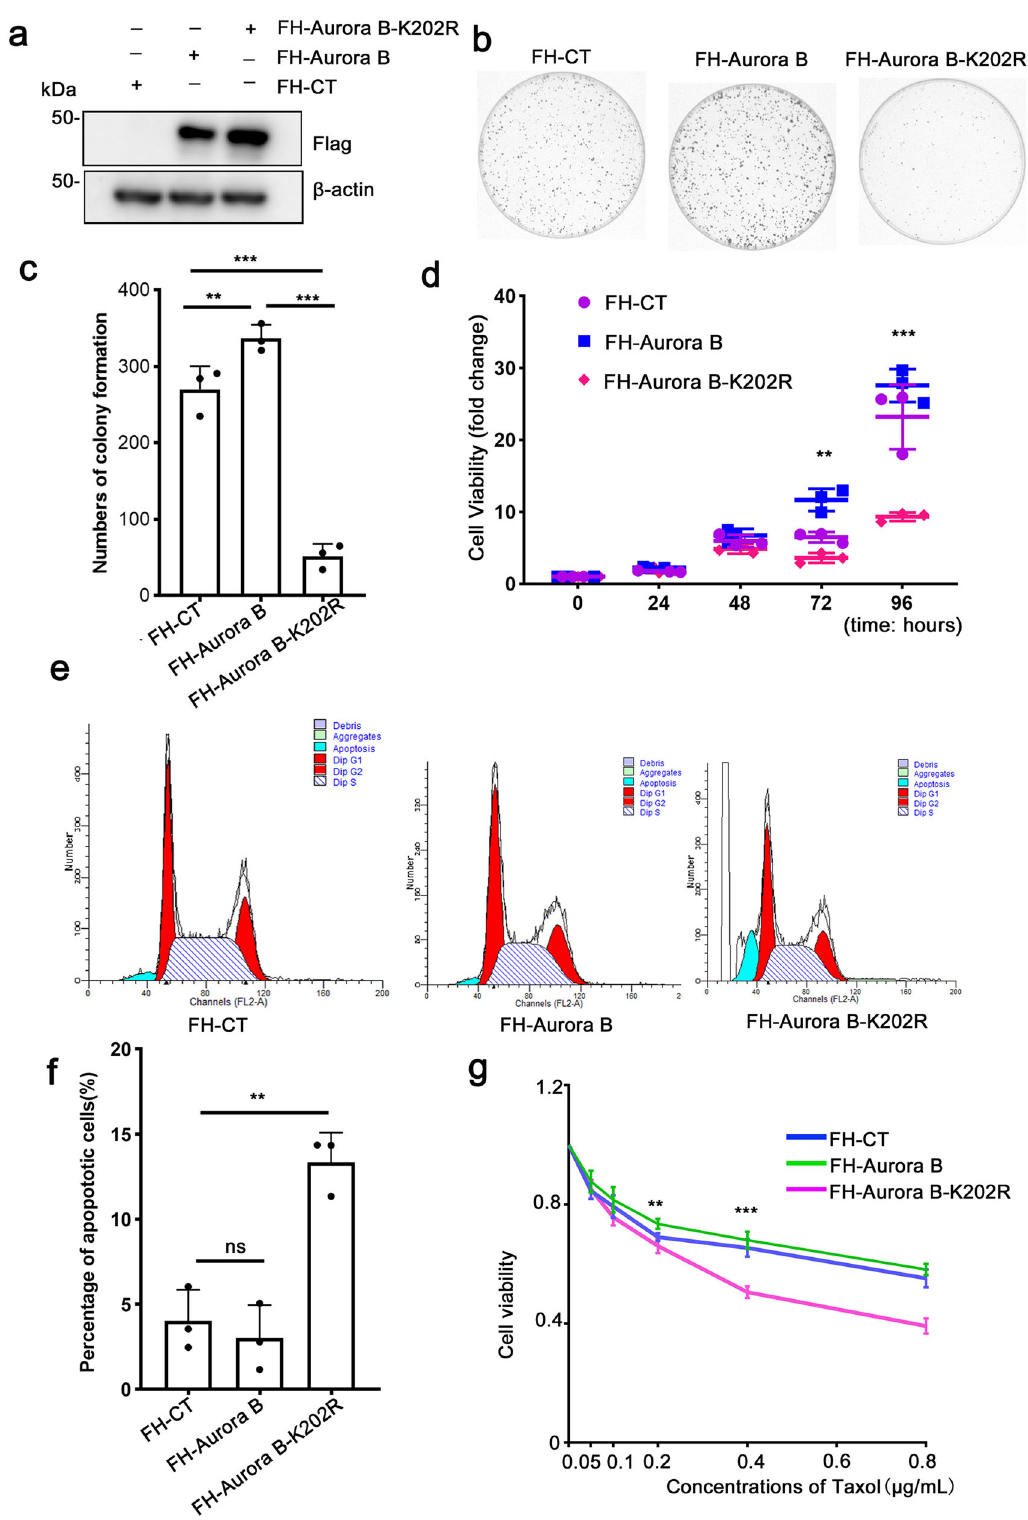
enhances the ef fi ciency of the anti-tumor drug Taxol. Thus, our fi ndings provide a potential site for Aurora B-targeting drug design, which might improve the sensitivity of Aurora B kinase